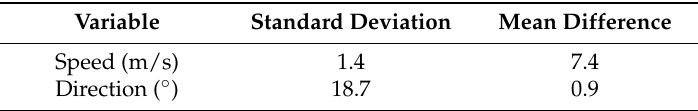
Table 2. Statistics of HR and NUIG wind